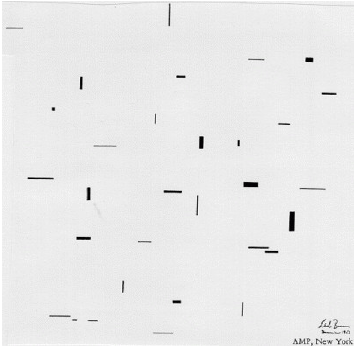
Figure 5. Earle Brown—“November 1952”